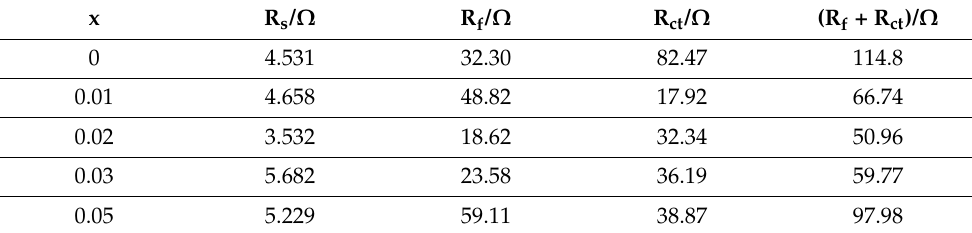
Figure 9. The Nyquist plots of Li[Ni 0.6 Co 0.2 Mn 0.2 ] 1-x Ga x O 2 electrodes: ( a ) after 3 cycles; ( b ) comparison after 50 cycles with 3 cycles for x = 0 and 0.02 electrodes. Table 1. Electrochemical impedance spectroscopy (EIS) fitting results of Li[Ni 0.6 Co 0.2 Mn 0.2 ] 1-x Ga x O 2 electrodes after 3 cycles.